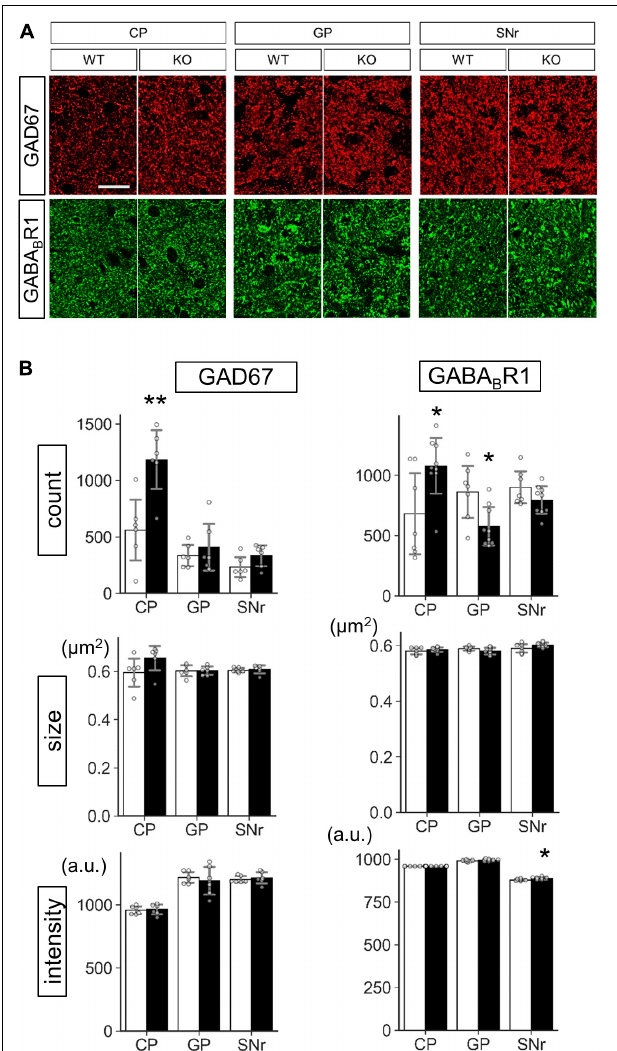
FIGURE 9 | Protein level analysis of Lrtm2 KO striatal projections. Protein levels were estimated by quantifying punctate immunopositive signals from each region after immunofluorescence staining. (A) Representative images. Error bars, SD. Scale bar, 20 µ m. (B) Mean of four sections is used as a representative value for a mouse. 10–12 week-old mice ( n = 6, 3 males and 3 females) were analyzed. Gray circles indicate the individual values, which are the means of six sections per mouse for each mouse. * p < 0.05; ** p < 0.01 in Student’s t -test. Error bars , SD. Additional results are indicated in Supplementary Figures 8–10 .